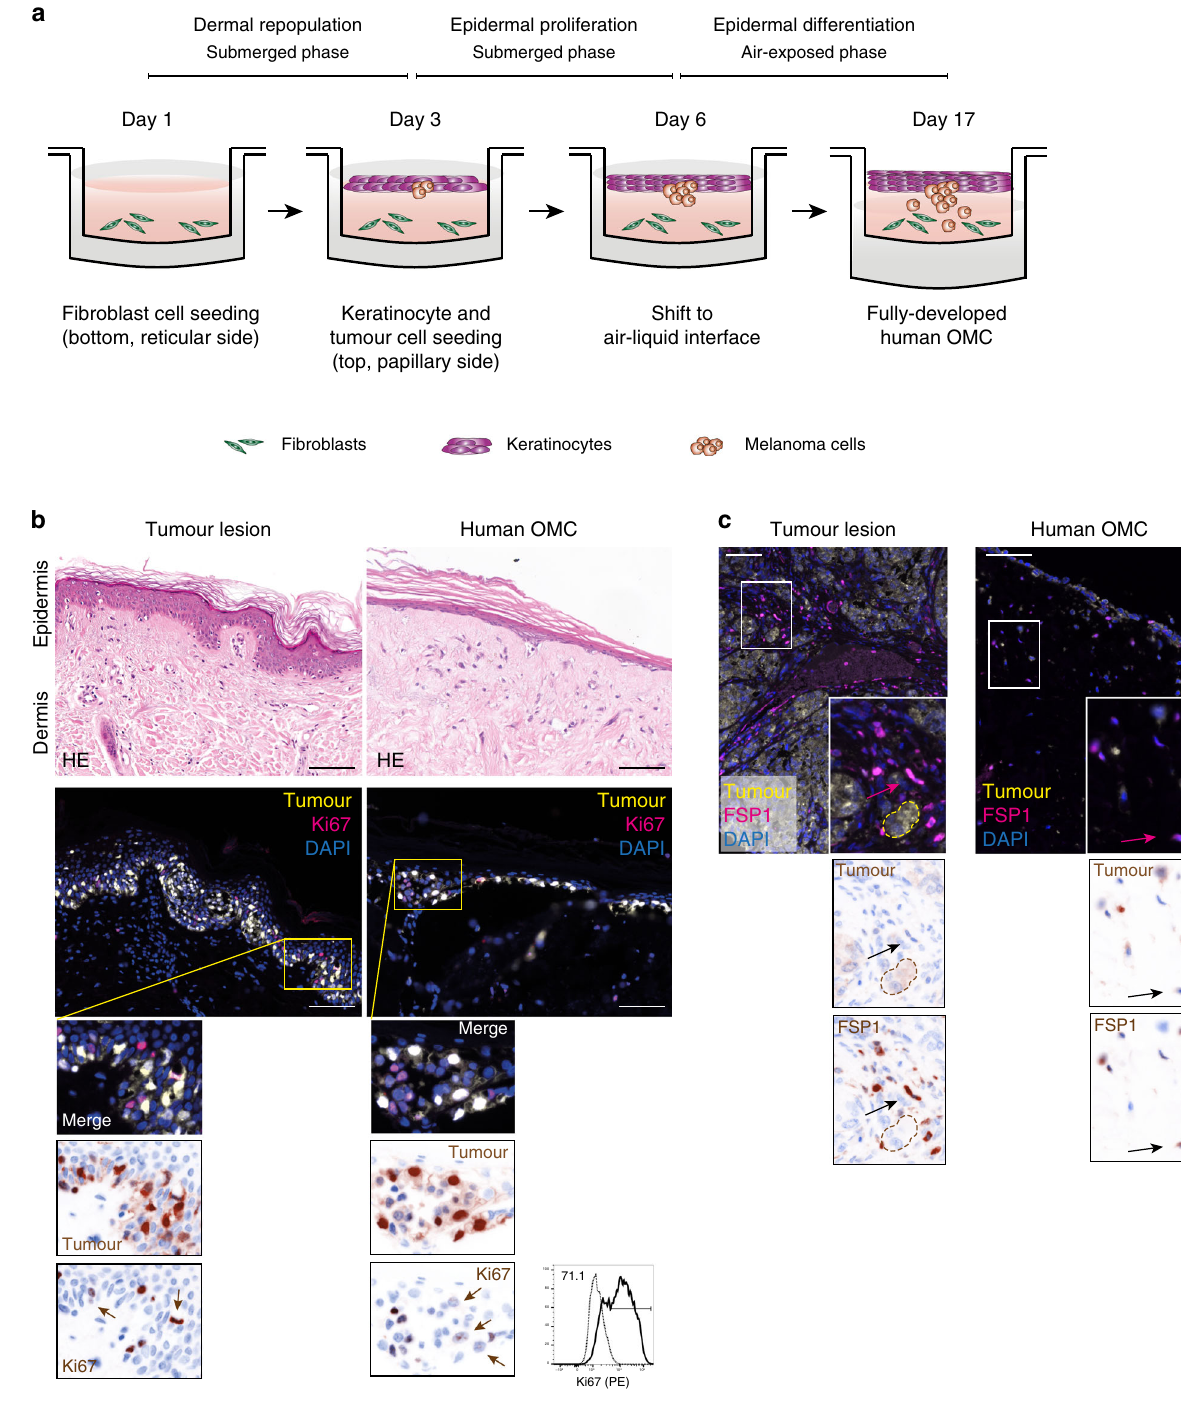
Fig. 1 Human OMC generation and characterization. a Overview of the OMC generation (prior to immune cell addition). b Histological comparison of tissue sections obtained from primary tumour lesion (left) and OMC (right), showing epidermal and dermal compartments with interspersed tumour cells. Haematoxylin-eosin staining, representative pictures ( n = 3). Representative areas ( n = 3) of primary tumour lesion (left) and OMC (right), showing triplex fl uorescent staining of Ki67 (magenta), tumour marker (yellow) and DAPI (blue) fl uorescence IHC staining. Composite and single colour images of higher magni fi cation are shown. Arrows indicate proliferating tumour cells. Representative fl ow cytometry histogram of Ki67 + cells measured within the OMC- digested live CD45-negative fraction. c Multiplex fl uorescence IHC shows representative area ( n = 3) of the tumour lesion (left) and the OMC (right) containing fi broblasts ( fi broblast-speci fi c protein 1, FSP1 + cells, magenta) and melanoma cells (tumour marker (tyrosinase and SOX10) + cells, yellow). DAPI (blue) indicates nuclei. Inserts show higher magni fi cation. Pseudo-DAB of isolated fl uorescent channels of the same areas are shown and fi broblasts are indicated with arrows. Scale bars, 100 μ m. Source data are provided as a Source data fi